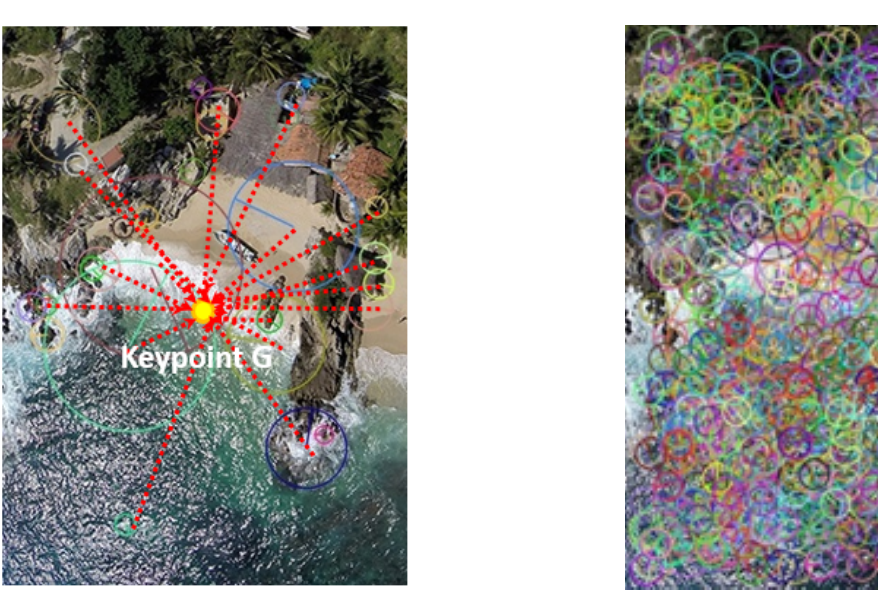
the imageset under